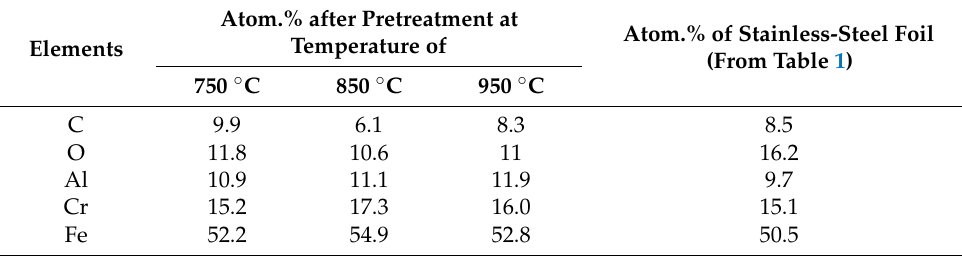
Table 2. Composition of the metallic particles on the surface of the catalyst precursor after pretreat-